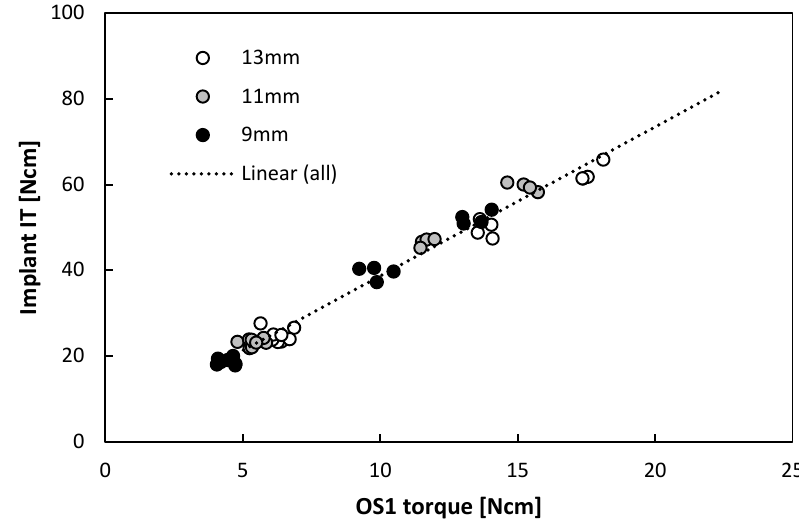
Figure 4. Liner regression of implant insertion torques versus OS1 insertion torques in 15 pcf and 20 pcf bone surrogate.